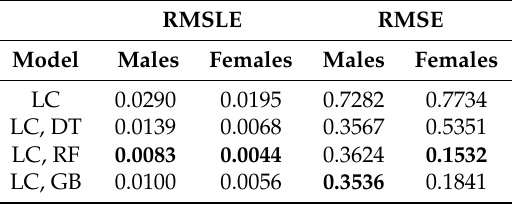
Table 4. Out-of-sample test results: RMSLE and RMSE for the LC model without and with machine learning. ML estimator ˆ ψ LC,ML x modeled according to the LC framework. Years 2000–2014